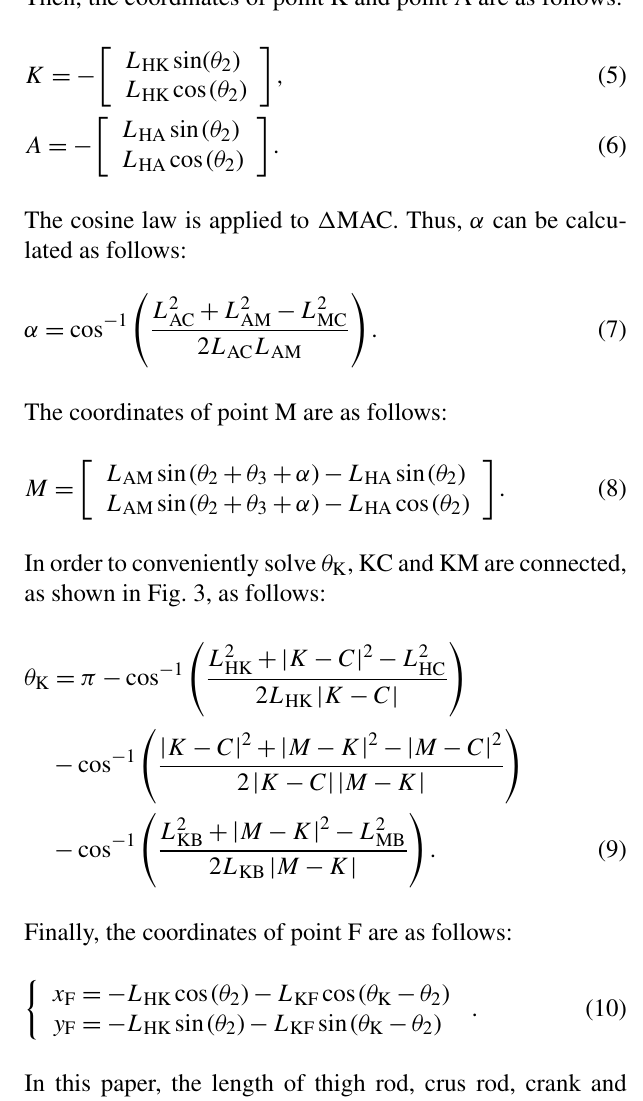
Figure 3. Coordinate system of the leg